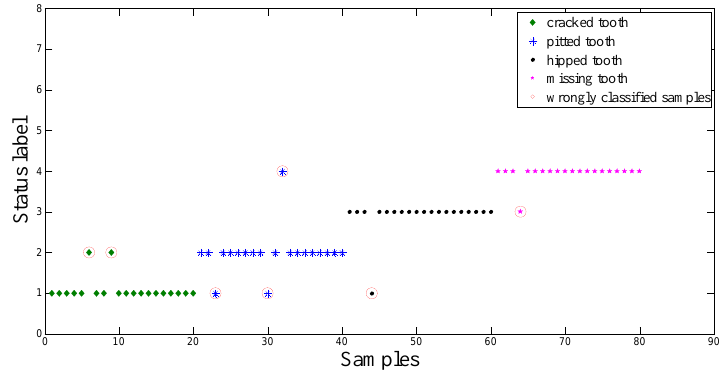
Figure 16. Classification result based on CV-RVM classifier in the planetary gearbox test.